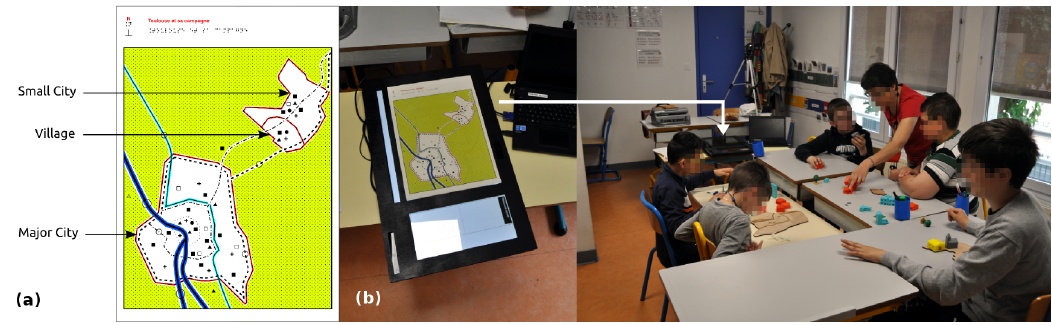
Figure 3. ( a ) the map design used during the second sequence; ( b ) the classroom